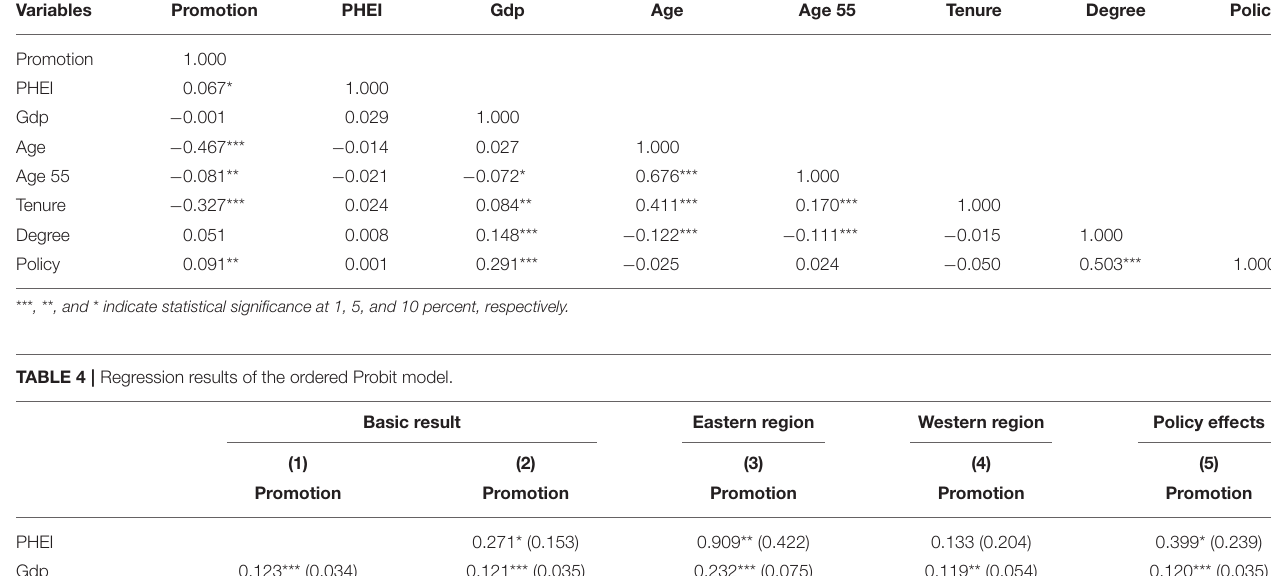
TABLE 3 | Pearson correlation coefficient matrix. Variables